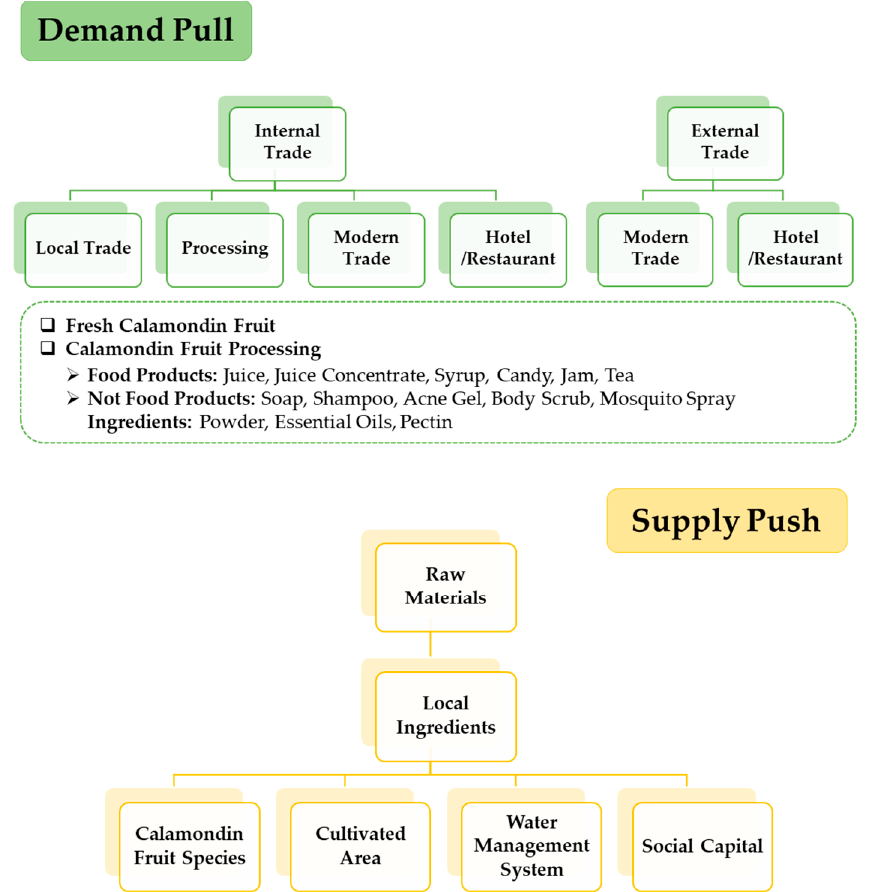
Figure 6. Demand and supply of calamondin fruit for commercial